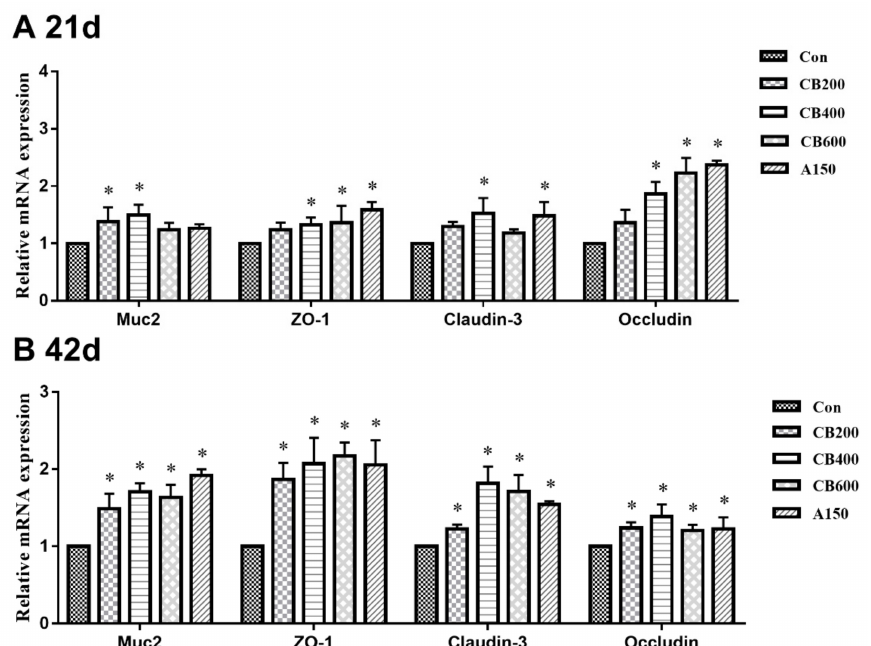
Figure 3. Effects of C. butyricum and aureomycin on relative mRNA expression of tight junction protein genes of intestine in Pekin ducks (N = 10 replicates per group). ( A ) The relative mRNA expression of tight junction protein genes at 21 d; ( B ) The relative mRNA expression of tight junction protein genes at 42 d. The superscript * indicate that there are significant differences ( p < 0.05) compared with the control group. Con, group Con; CB200, group CB200; CB400, group CB400; CB600, group CB600; A150, group A150.